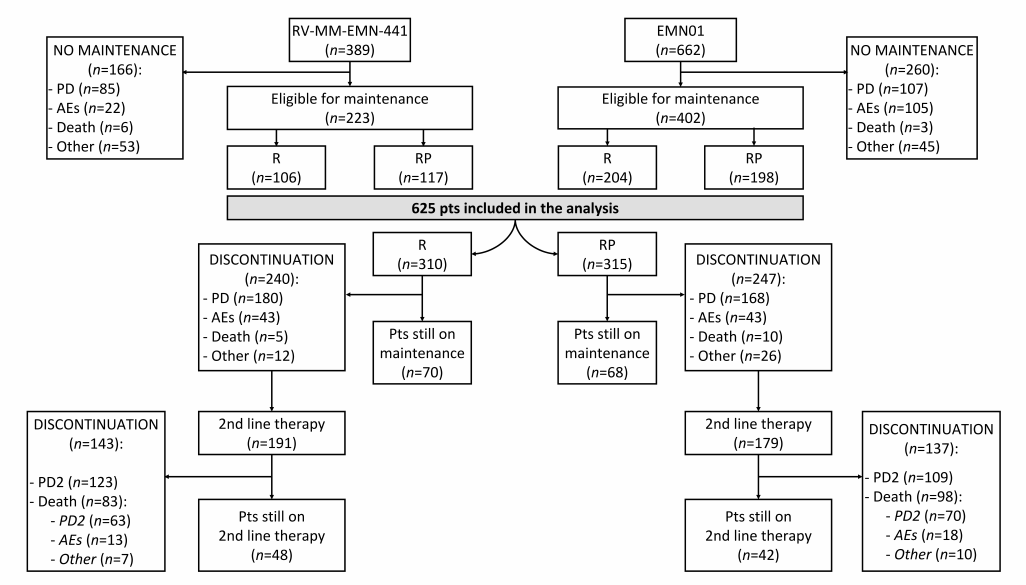
Figure 1. Study flow. Abbreviations: n , number of patients, R, lenalidomide; RP,